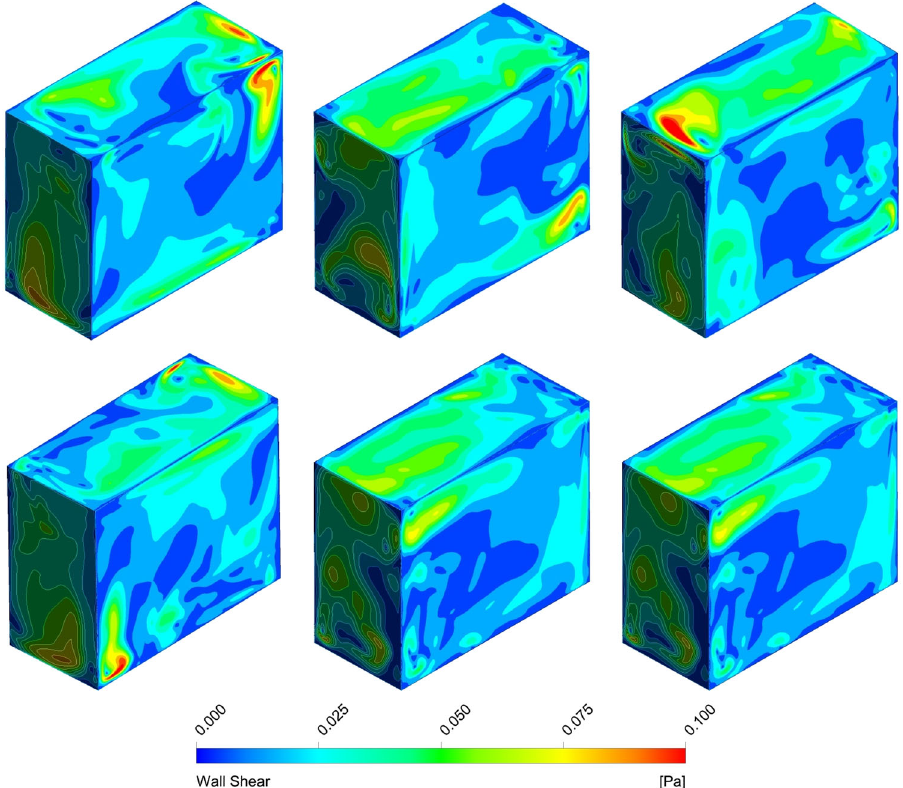
Fig. 3 Simulated shear stress values along the walls in an RPM. Shear stress values vary throughout with no clear steady state. Reprinted from Wuest et al. 58 with no alterations under the CC BY 4.0 License (https://creativecommons.org/licenses/by/4.0/).